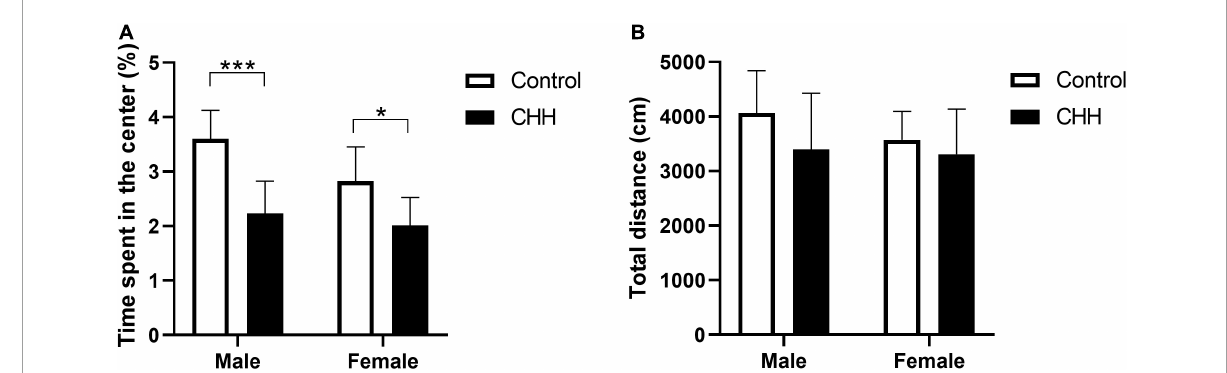
FIGURE2 Chronic hypobaric-hypoxia (CHH) exposure induced anxiety-like behavior in rats. (A) Percentage of time spent in the center area in the OFT for male and female rats; (B) total distance. CHH, chronic hypobaric hypoxia. Values are means ± SD for eight animals/group. Data for male and female rats, with or without CHH exposure, were analyzed using two-way ANOVA. Post hoc analysis indicated: * p < 0.05, ** p < 0.01, *** p < 0.001.